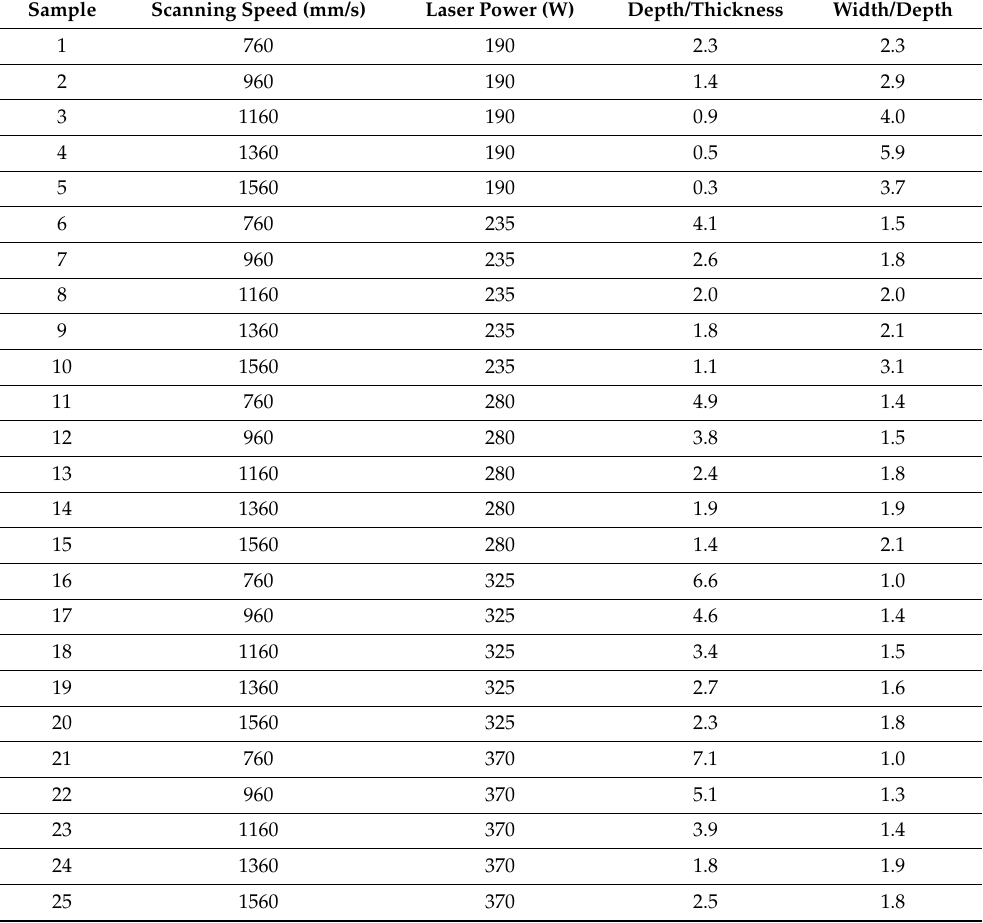
Table 7. Melt pool dimensions tracking